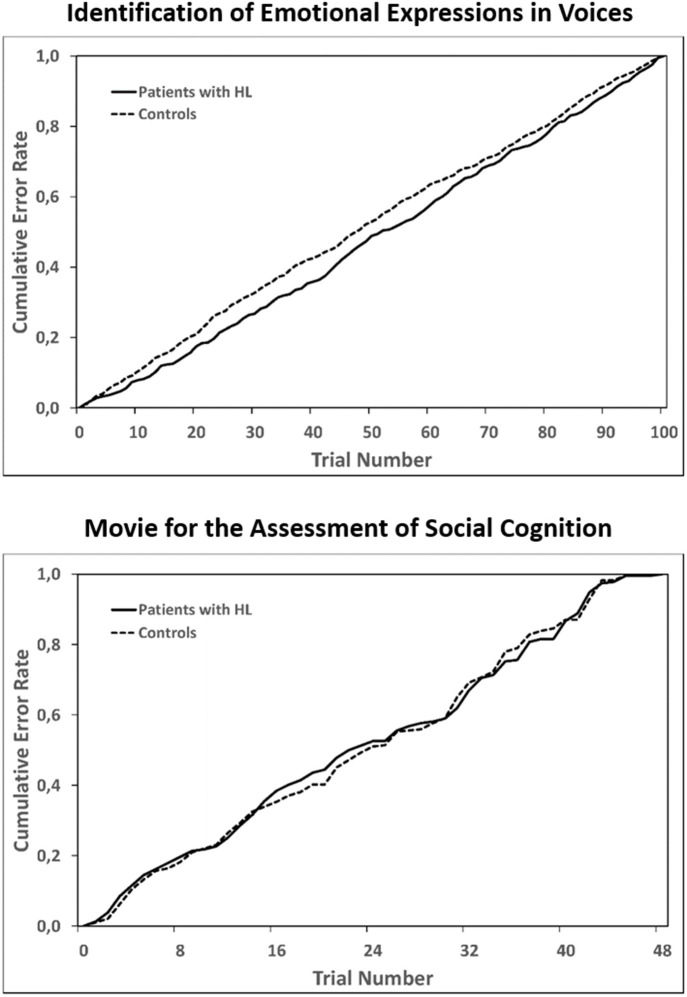
Cumulative error rates across all trials of the two longer tasks: Identification of Emotional Expressions in Voices (upper panel) and the Movie for the Assessment of Social Cognition (lower panel). For each group separately, errors in each trial were summed up across participants and error rates for each trial were then computed as a proportion of all errors within a group. Statistical testing with the Kolmogorov Smirnov test for two independent samples to test for equality of the two distributions in each of the task revealed no significant differences between patients with HL and healthy controls.